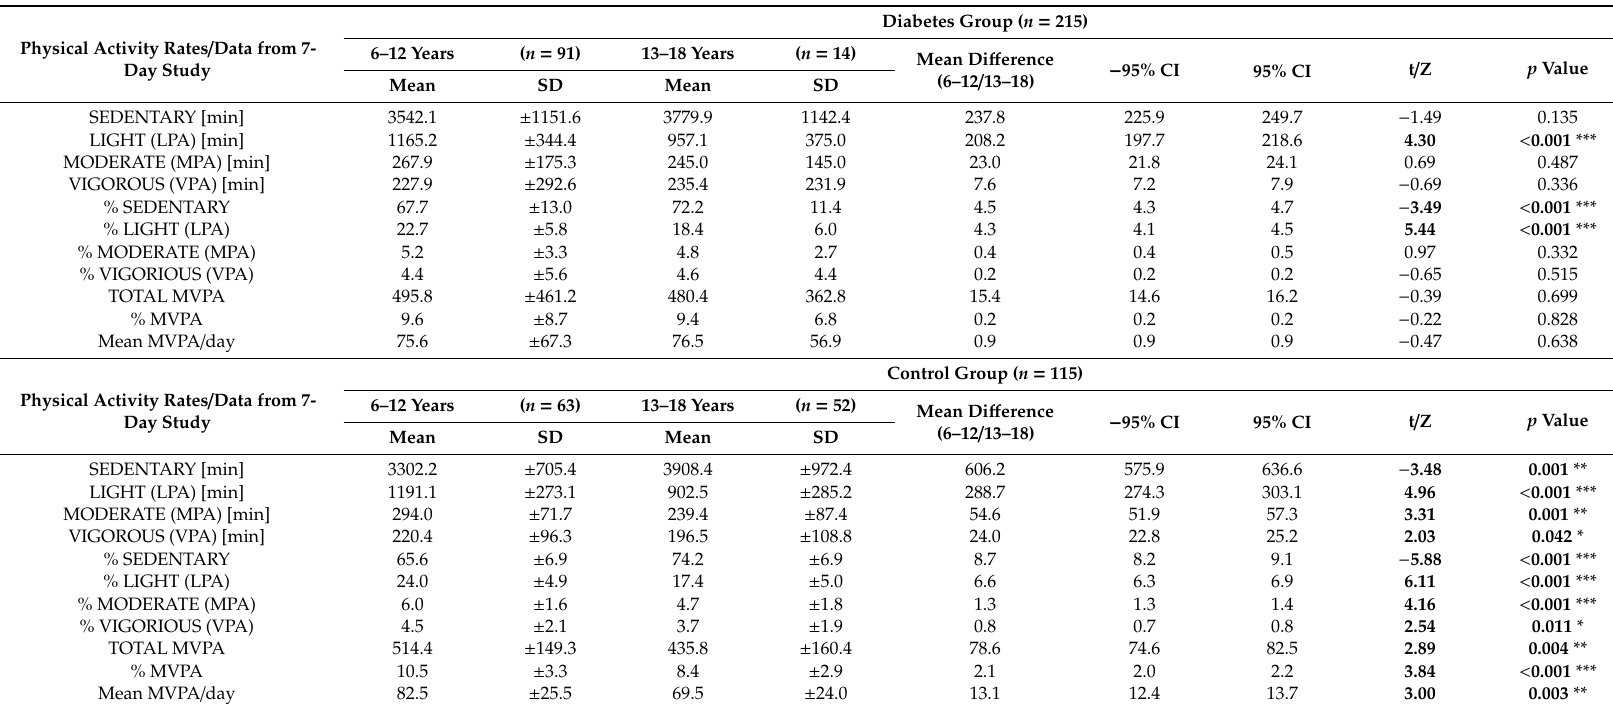
Table 7. Physical activity rates in the diabetes and the control groups depending on